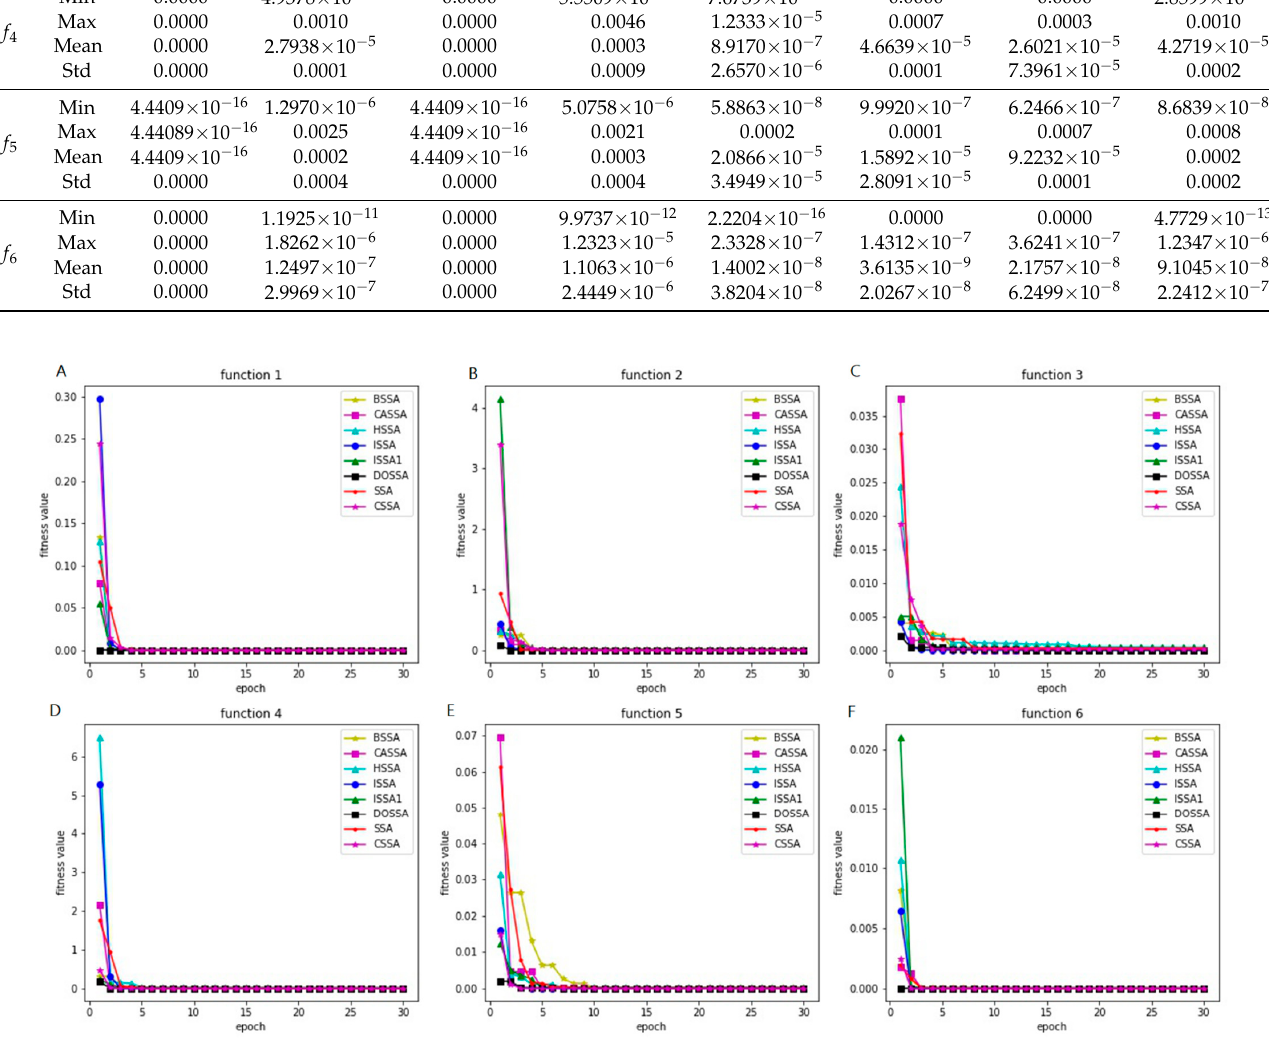
Figure 3. Convergence curve of algorithms on unimodal functions and multimodal functions. Subgraphs ( A – F ) represent